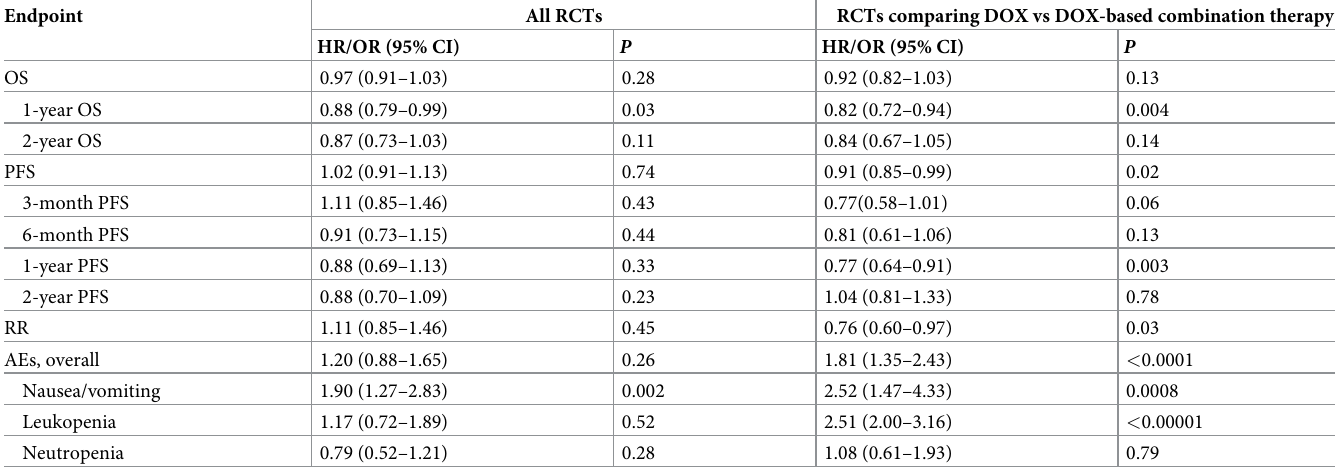
Table 3. Summary of the meta-analysis.